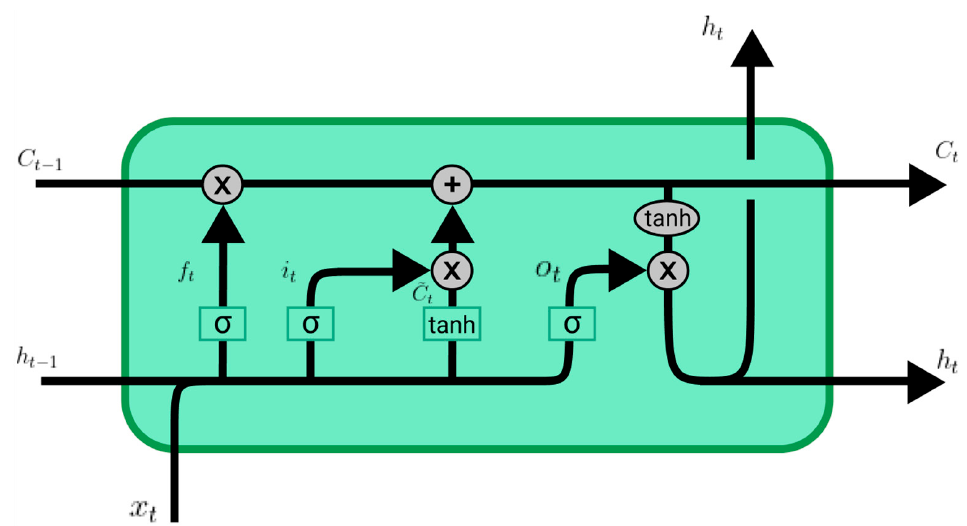
Figure 2. Graphical representation of an LSTM Cell.